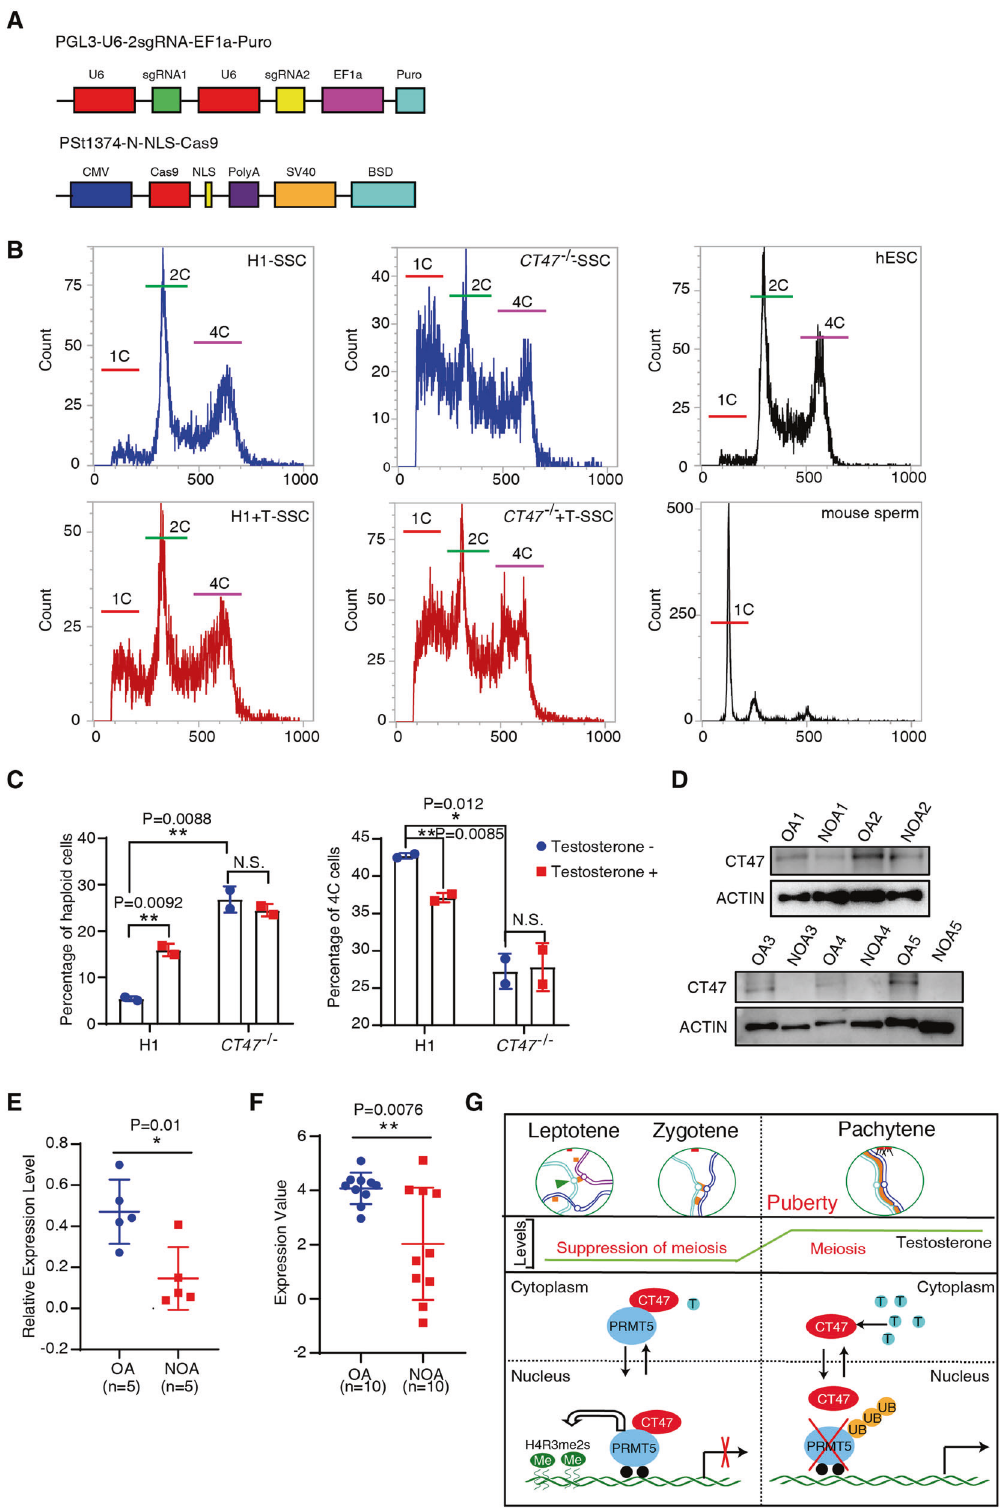
CT47 and PRMT5 colocalized in the testis, and degradation of PRMT5 was inhibited, resulting in a high nuclear PRMT5 accumula- tion during the leptotene/zygotene-to-pachytene transition. In vertebrates, the hypothalamic-pituitary-gonadal axis is responsible for the neuroendocrine control of reproductive processes. Although spermatogenetic development is